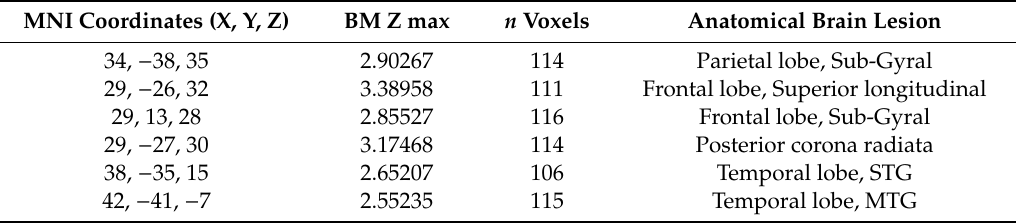
Figure 2. Statistical voxel-based lesion-symptom mapping. The nonparametric Brunner–Munzel statistical analysis was used for the continuous peak cough flow. Color scale indicates Brunner–Munzel rank order z-statistics. Only voxels significant at p < 0.05 are shown. Colored bar represents the zstatistics. WesetthemaximumrangeoftheZscoreas4, whichareshownwiththemaximumbrightness. Table 2. Stroke lesions related to voluntary cough